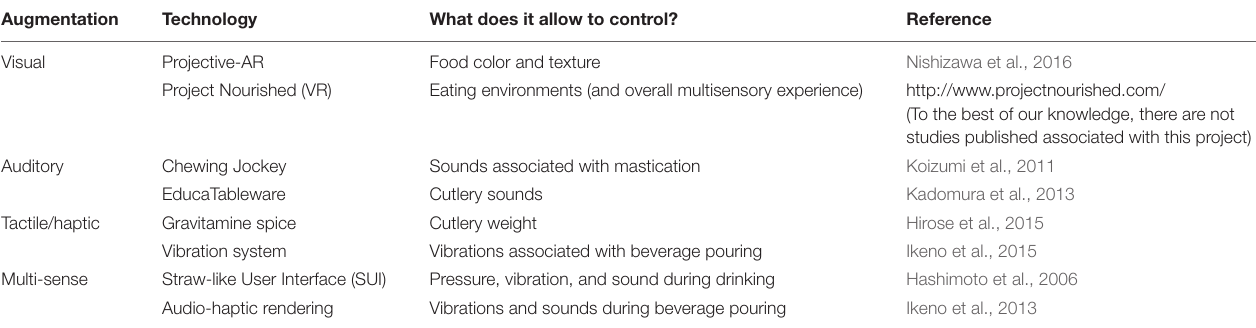
TABLE 1 | Examples of multisensory technologies for flavor augmentation based on extrinsic cues associated with the flavor and food/drink